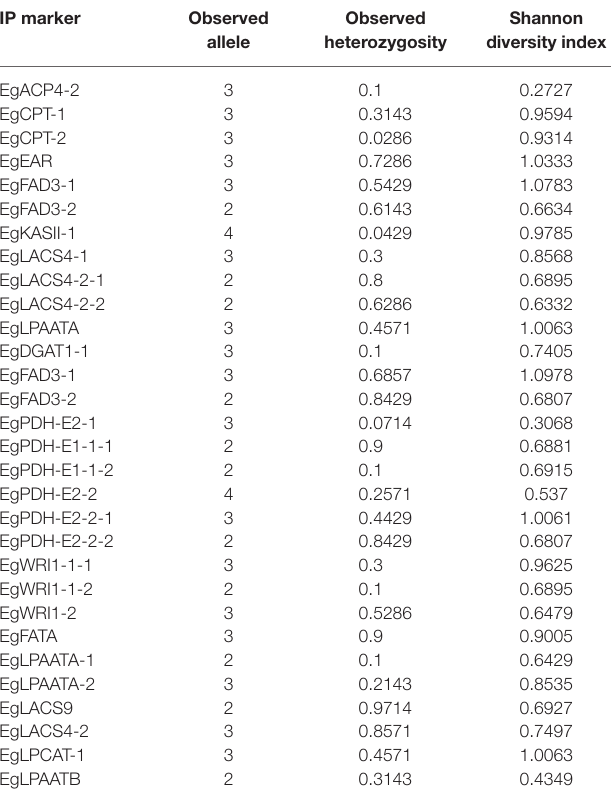
TABLE 1 | Polymorphism information of IP markers developed in the study. IP